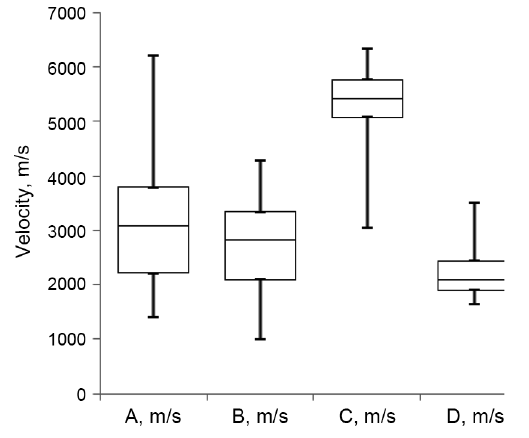
Fig. 3. Box plot charts of ultrasound velocities: A) indirect measuring with a spacing of 200 mm on the tangential surface; B) indirect measuring with a spacing of 600 mm on the tangen- tial surface; C) longitudinal direct measuring between the end surfaces in the longitudinal direction; D) transversal direct measuring in the radial direction Machado et al. (2009) found that the relative differ- ence between direct and indirect measurements of defect- free specimens was ±10%, which shows a good relation- ship between the results of the different ultrasound meas- uring methods. Thus, the use of the indirect method on site, where only one side of the wood structure is accessi- ble, is